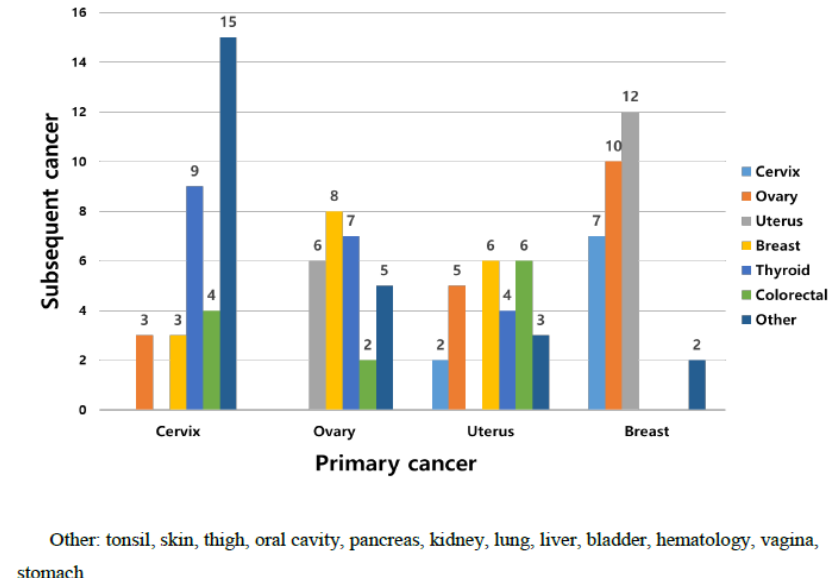
Figure 2. Frequency of subsequent cancer according to primary cancer